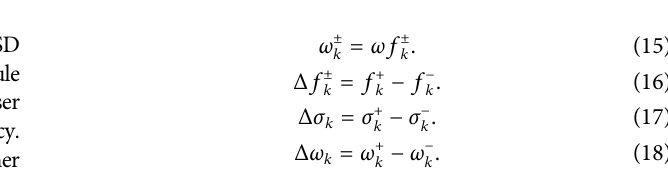
Supplementary Table S3 . The calculated Fukui indices ( Supplementary Table S3 ) support the electron distribution of